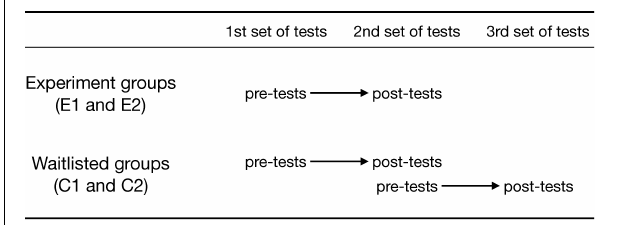
FIGURE 1 | The structure of the experiment. All sets of tests are identical at each timepoint. Note that the second set of tests undertaken by the waitlisted control group serve as the post-test relative to their first set of tests; but they serve as the pre-test to their third set of tests (which are